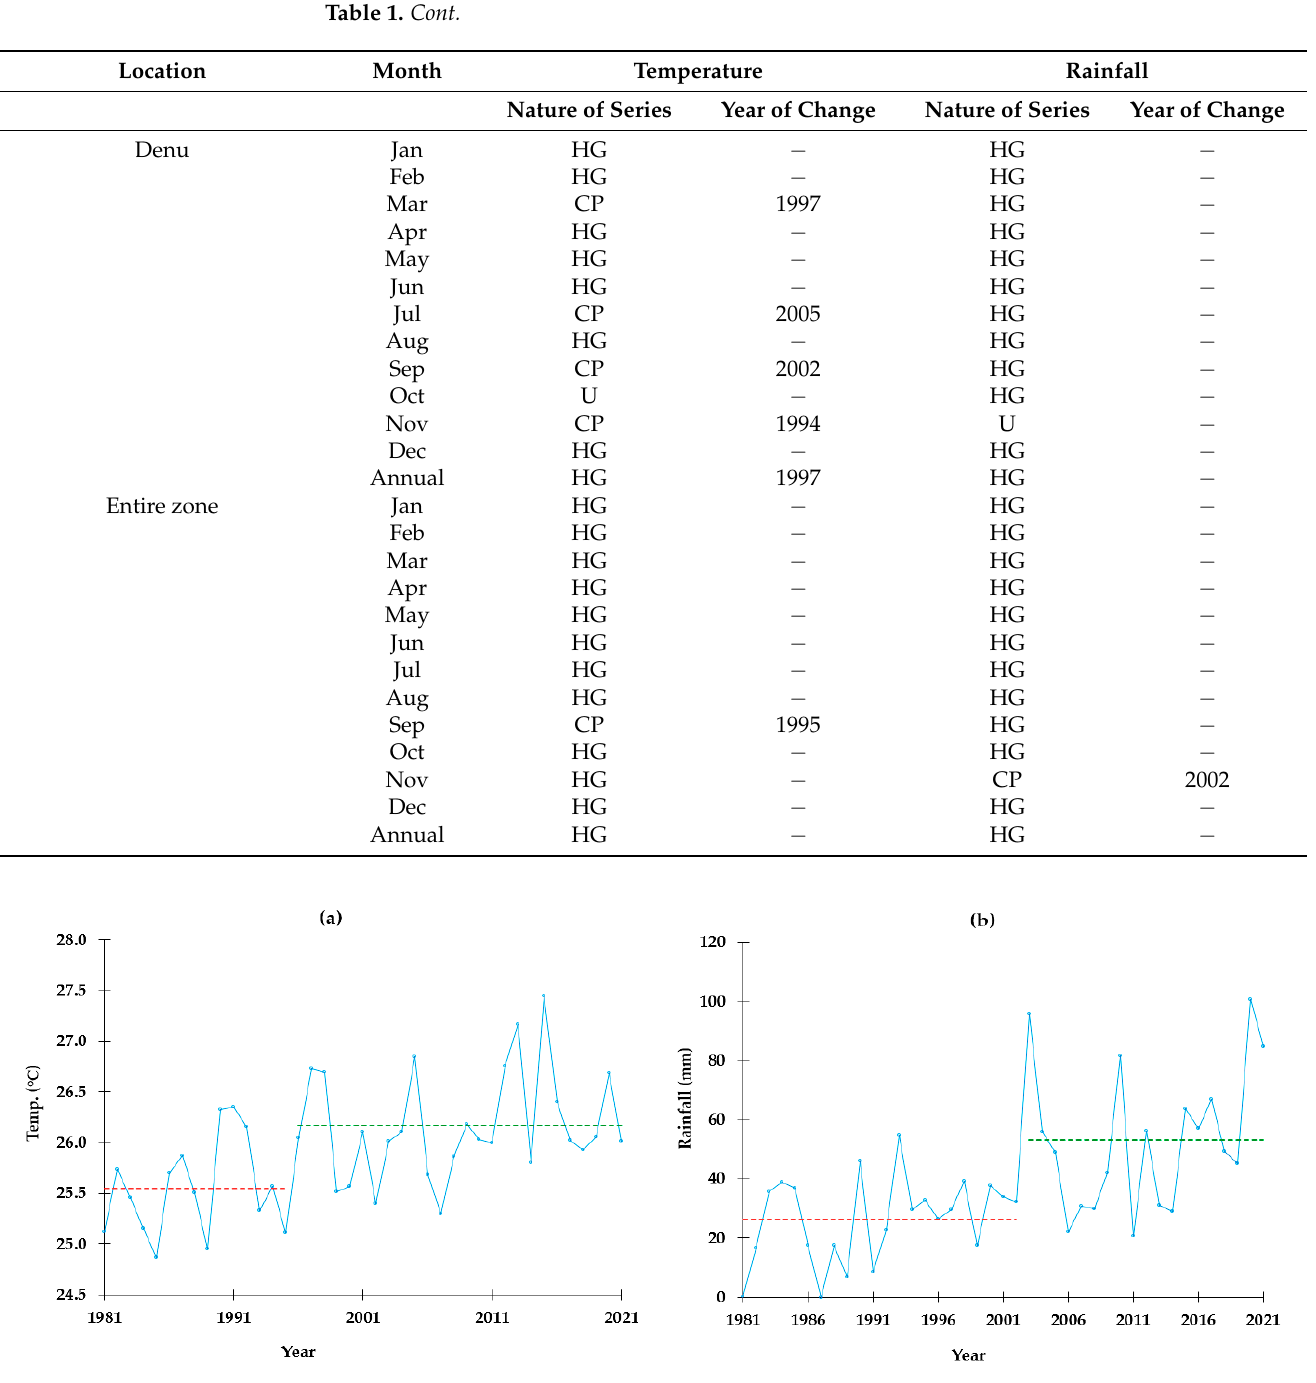
Figure 2. Changepoints in September temperature ( a ) and November rainfall ( b ) for the coastal Savannah agroecological zone of Ghana.